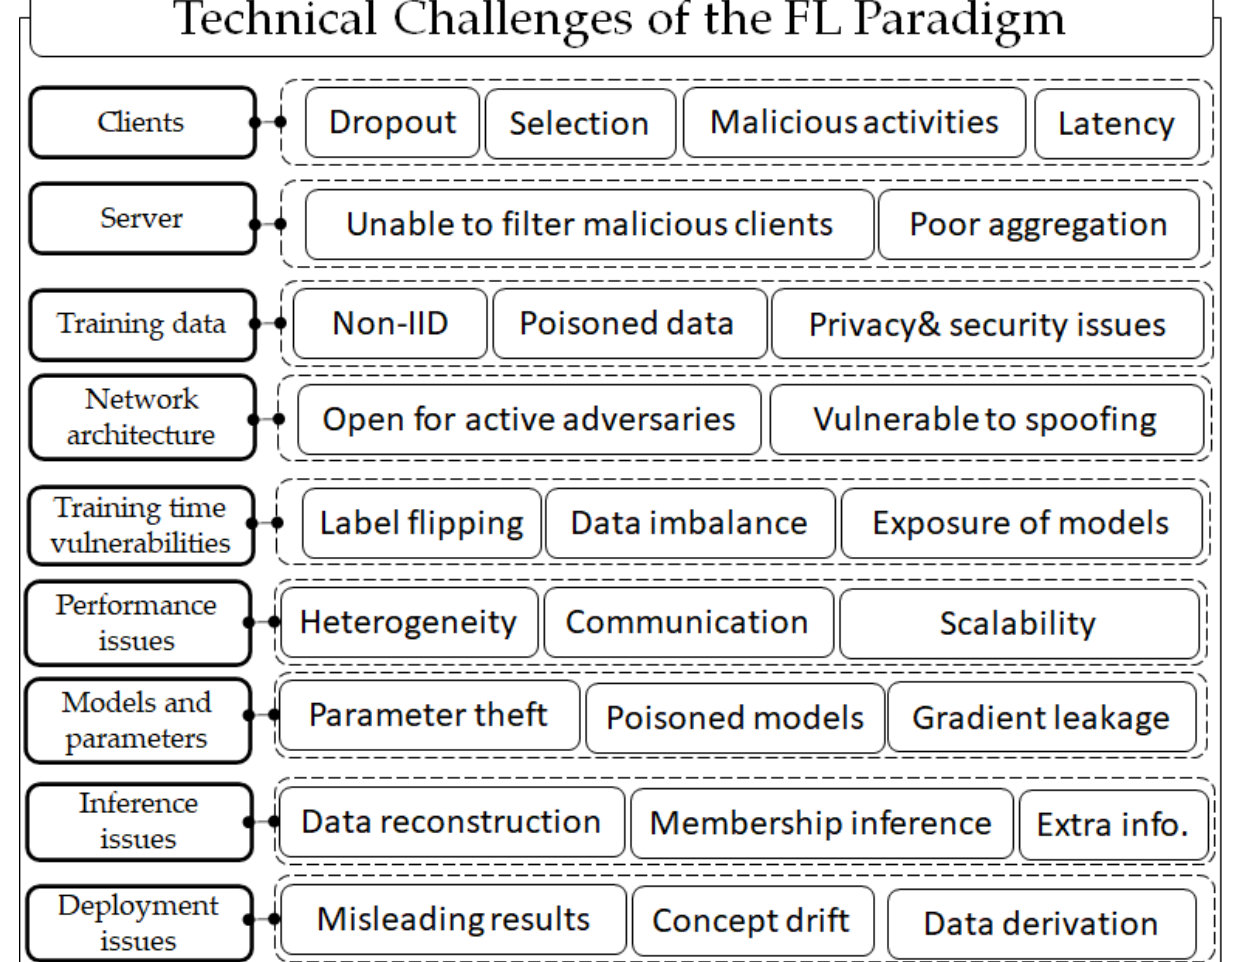
Figure 7. Technical challenges of the FL paradigm from the perspective of